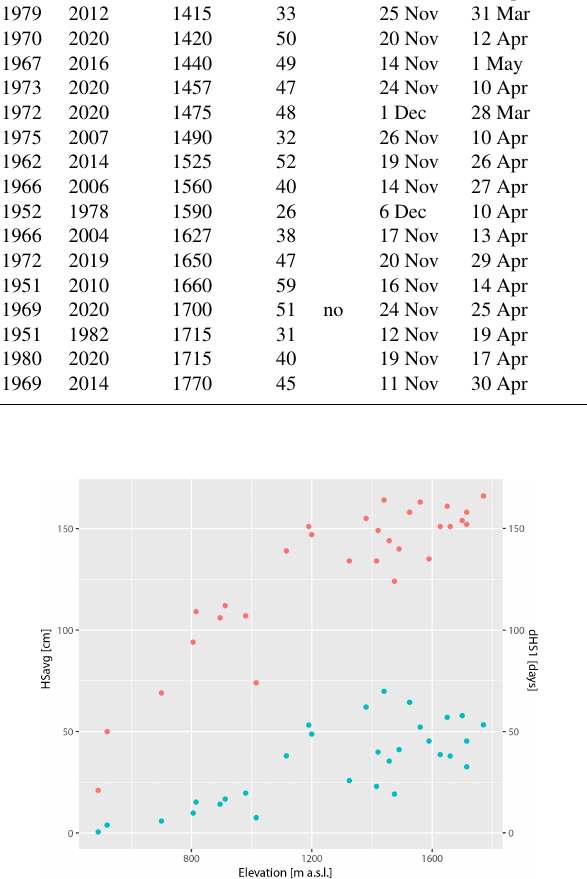
Figure A1. Shown in green are mean values of average snow depth (HSavg), and shown in red are mean values of days with snow on the ground (dHS1) for each station pair and NDJFMA. Station pairs are ordered according to their